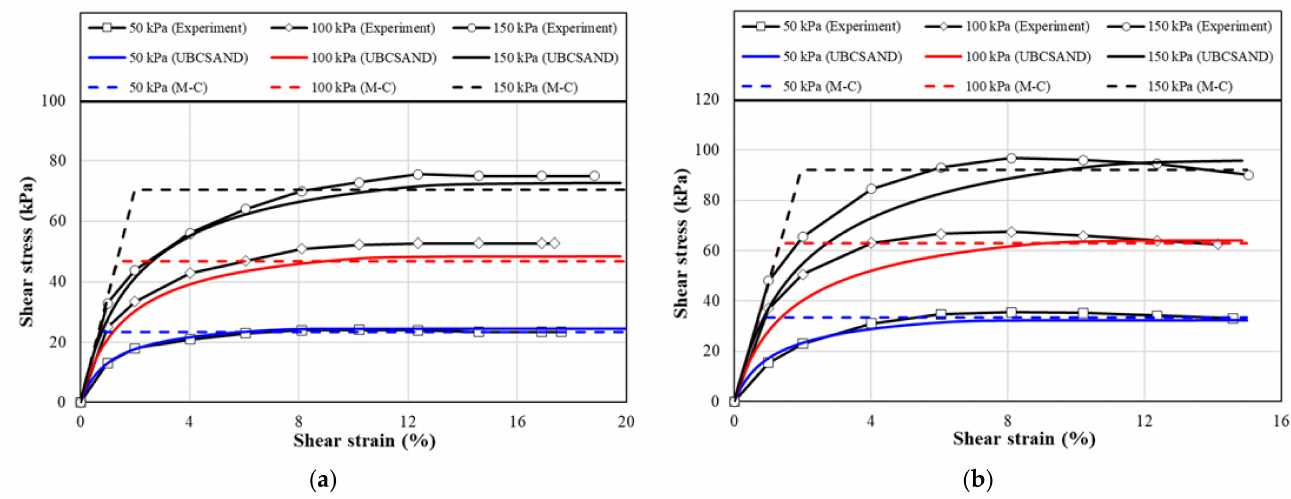
Figure 3. Behavior of tailings materials during drained simple shear tests and simulations: ( a ) layered tailings with dry density of 1.65 t/m 3 and ( b ) compacted tailings with dry density of 1.82 t/m 3